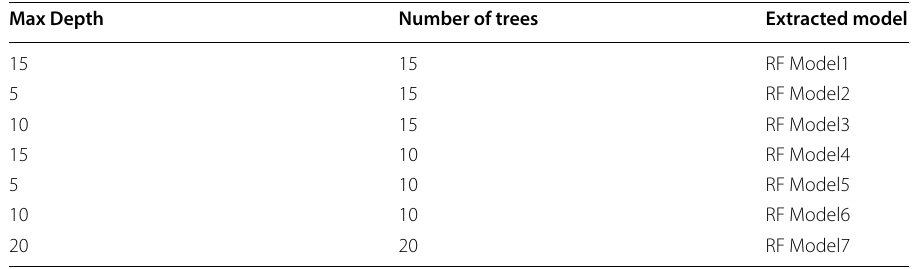
Table 6 RF models